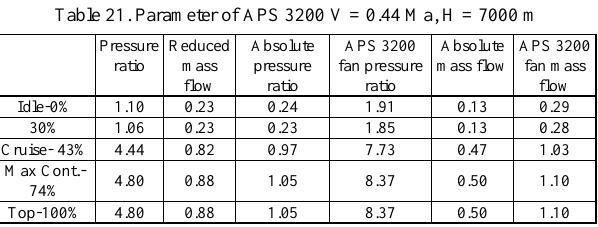
Table 21. Parameter of APS 3200 V = 0.44 Ma, H = 7000 m Pressure Reduced ratio mass